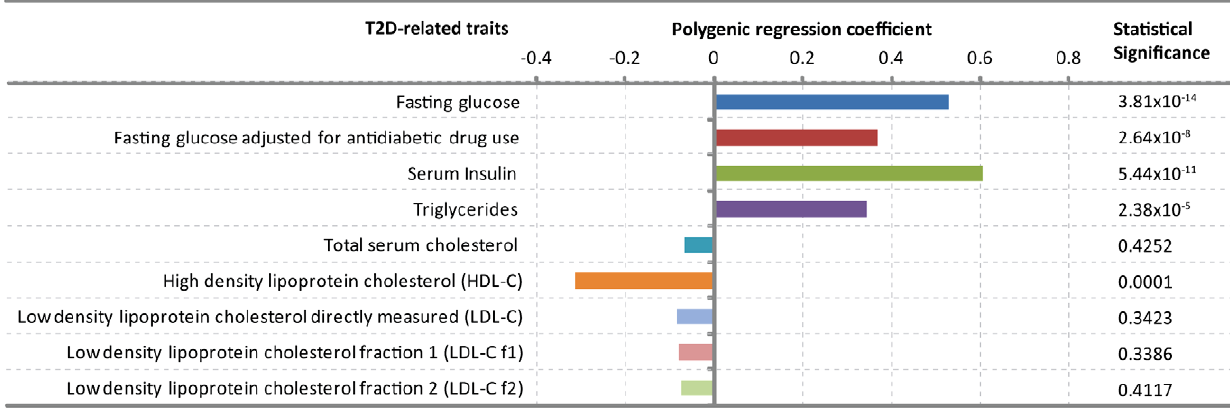
Figure 2. Association of dichotomized WC with T2D-related traits. The bars represent regression coefficients estimated using polygenic regression models.